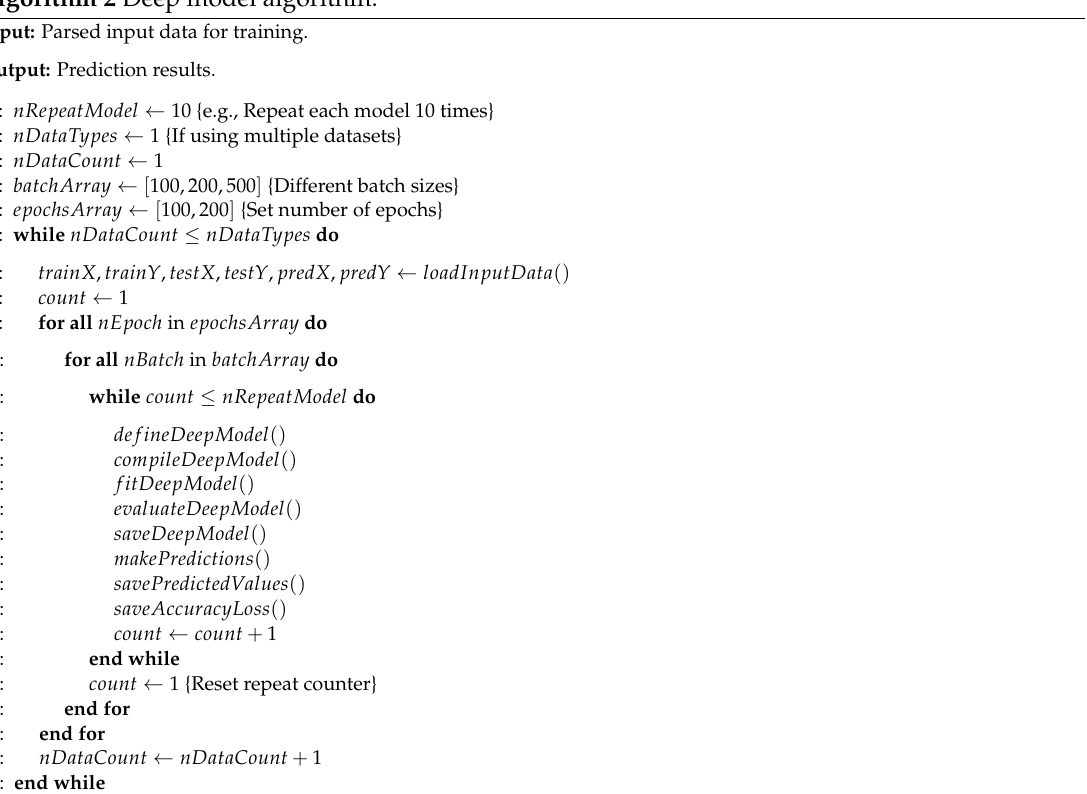
Algorithm 2 Deep model